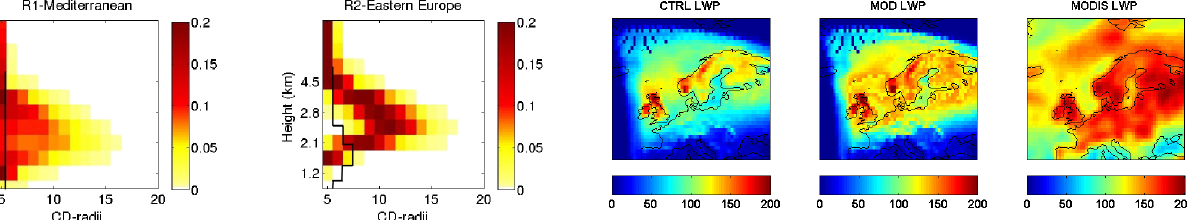
Figure 8. Joint histograms of CD radii (µm) vs height averaged over JJA months in MOD simulation and the solid line shows the same in CTRL simulation. The colour scale shows the normalized fre- quency.